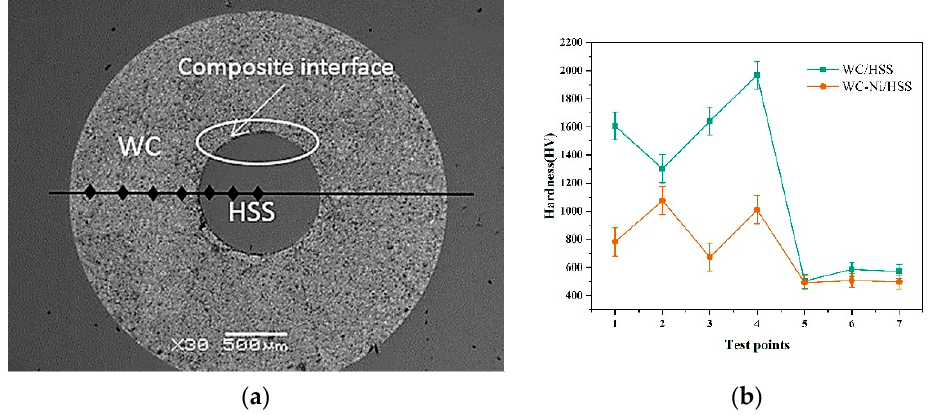
Figure 9. Comparison of the effect of adding Ni element on ( a ) dot position, and ( b )